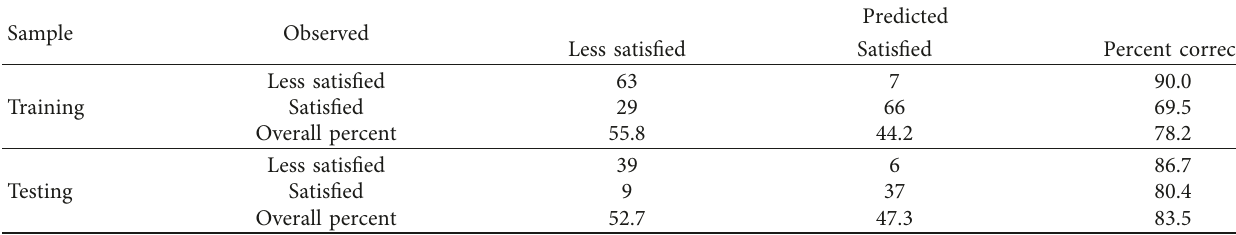
Table 15: Classification table.